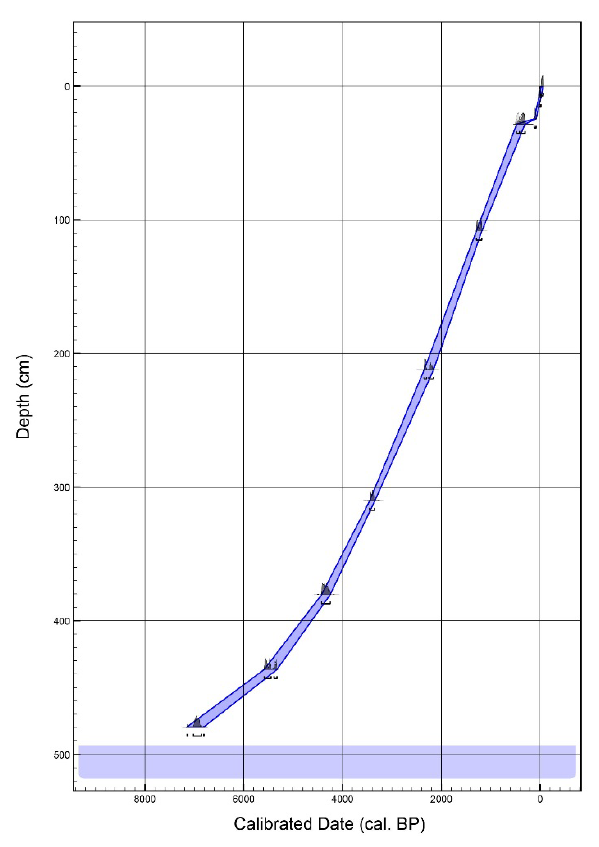
Figure 3. Bayesian (P_Sequence) age-depth model from seven accepted AMS radiocarbon dates and relative dates from SCPs constructed using OxCal version 4.2 software (Ramsey 2009) and